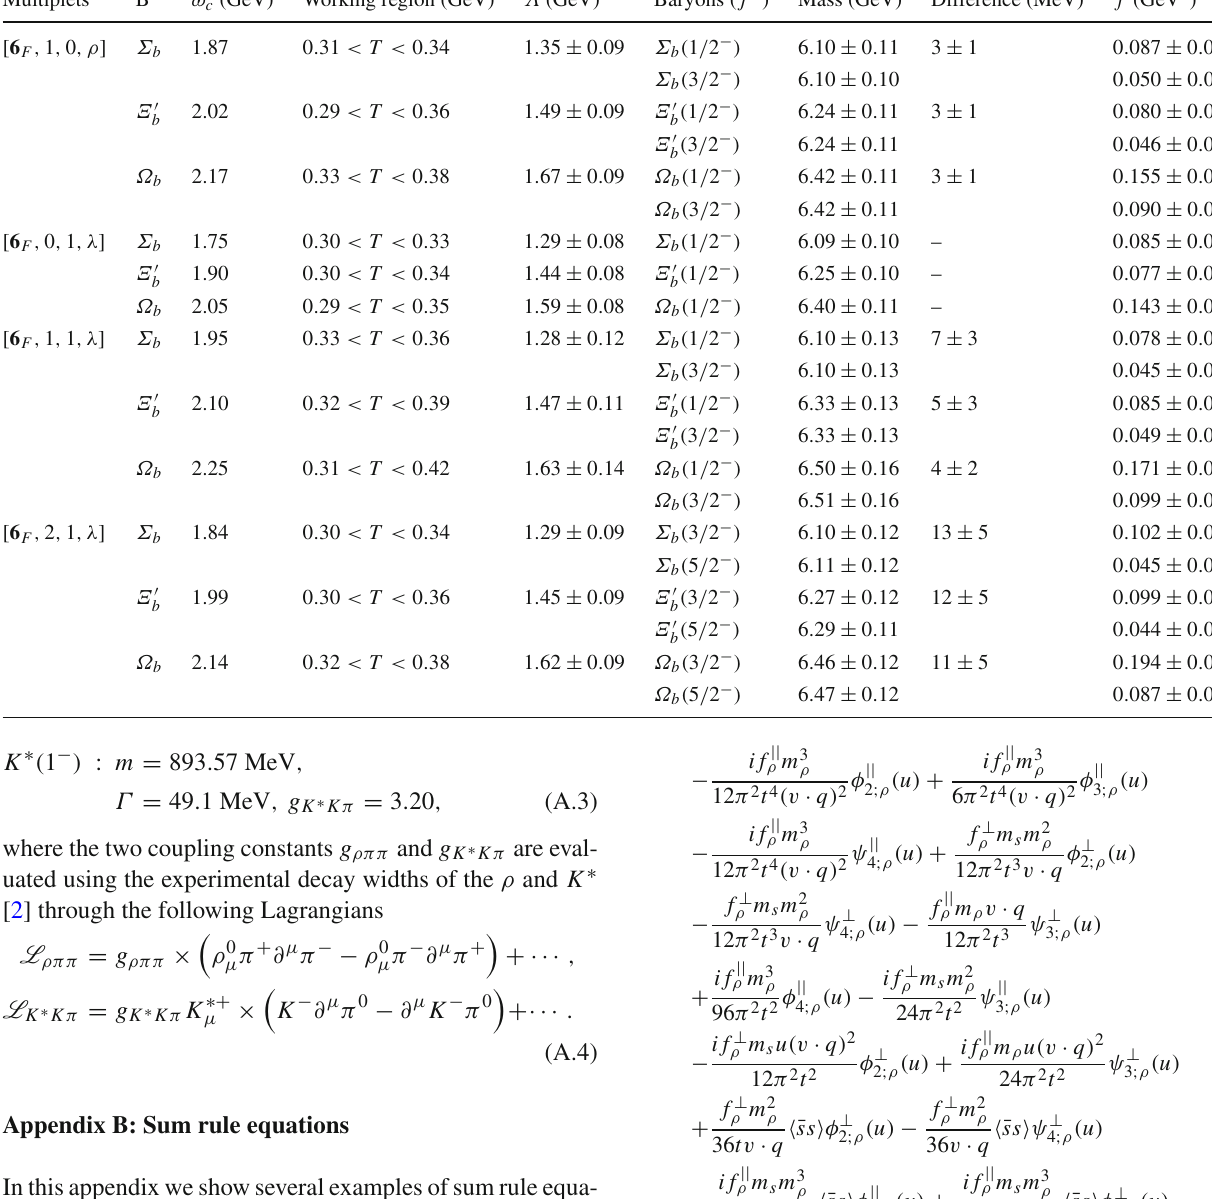
Table 5 Parameters of P -wave bottom baryons belonging to the bottom baryon multiplets [ 6 F , 1 , 0 ,ρ ] , [ 6 F , 0 , 1 ,λ ] , [ 6 F , 1 , 1 ,λ ] and [ 6 F , 2 , 1 ,λ ] . Detailed discussions can be found in Refs. [1,58,59]